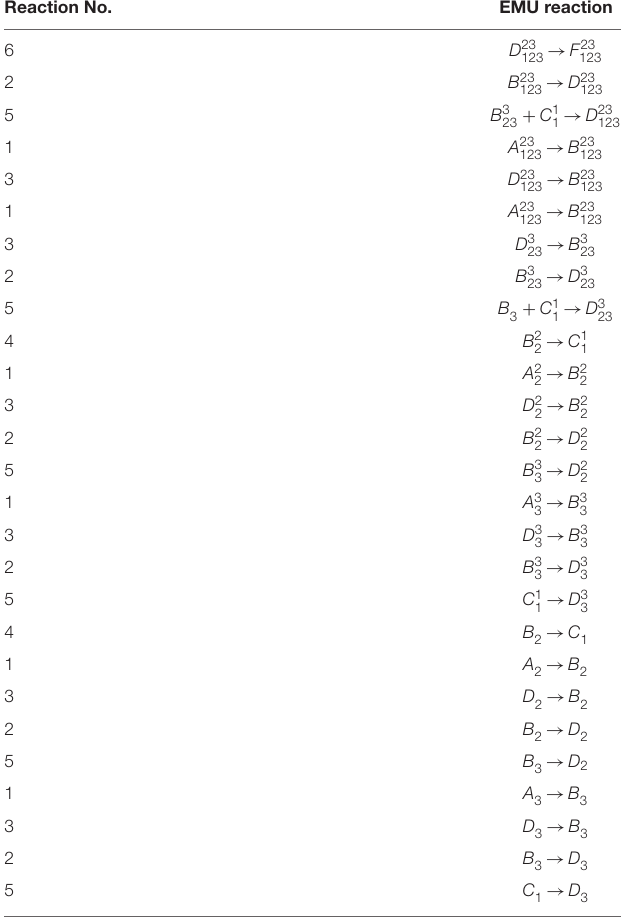
TABLE 2 | EMU decomposition for F 23 123 in the example metabolic network. Reaction No.